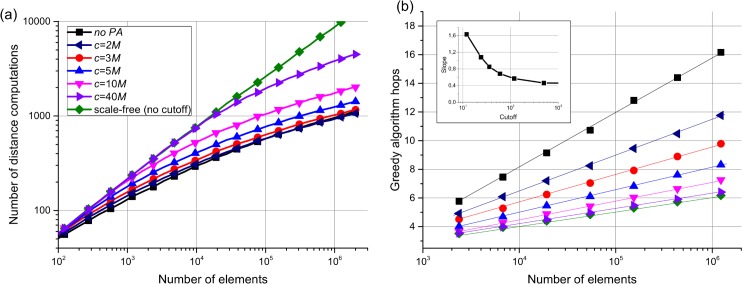
Comparison of the GH model to the GH model with PA.(a) Number of distance computations per a greedy search for GH network with PA for different degree cutoffs (kc). (b) Average hop count during a greedy search for GH network with PA for different degree cutoffs. The inset shows the decay of greedy hop slope with an increase of the degree cutoff. Both plots are presented for Euclid data with d = 2, M = 12.